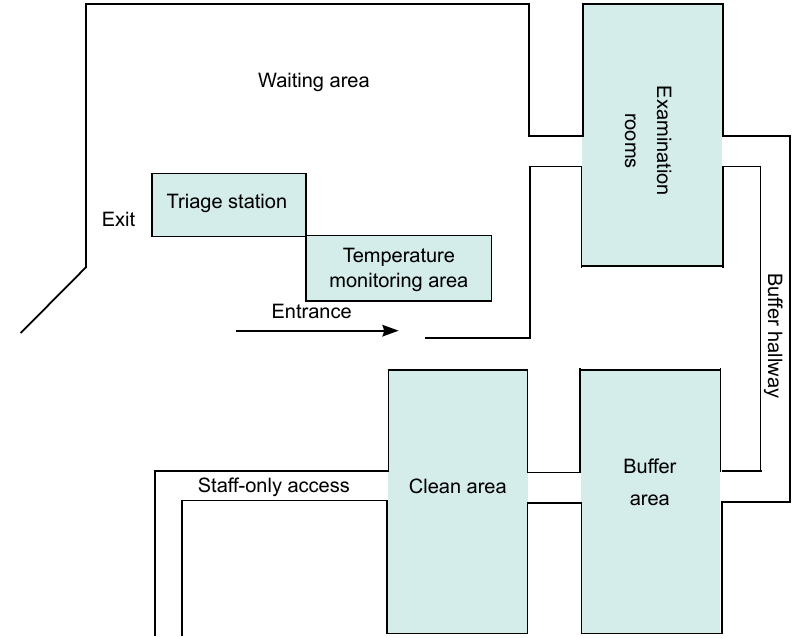
Figure 1 The schematic diagram of diagnostic ultrasound examination area